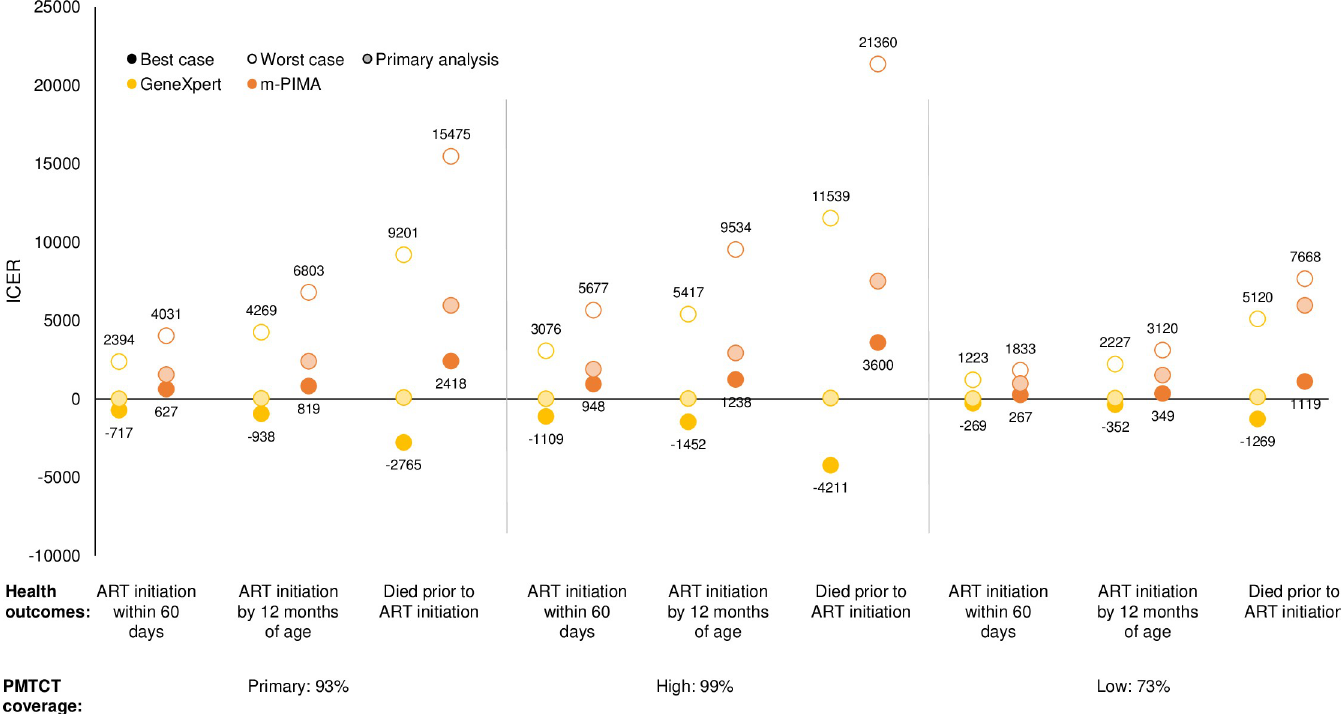
Fig 5. Incremental cost-effectiveness ratios for multivariate sensitivity analysis showing best and worst cases by PMTCT coverage. ART: antiretroviral therapy; ICER: incremental cost-effectiveness ratio; PMTCT: prevention of mother-to-child transmission. Note: All sensitivity analyses were performed with the PoC3 algorithm and primary implementation model. See S1 and S7 Tables for the list of parameter values for the primary analysis, best case, and worst case